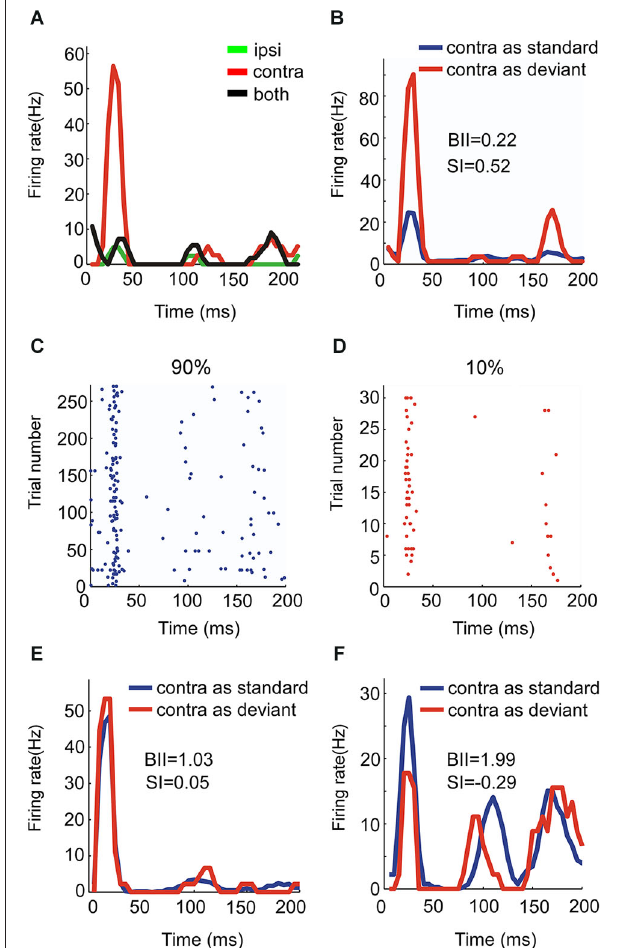
FIGURE 3 | Responses of EO neurons to noise burst with two locations presented in oddball procedure. (A) Peristimulus time histograms showing one neuron’s monaural and binaural responses respectively. (C, D) Raster displays showing its responses to 270 times of standard (90% appearing probability) and 30 times of deviant (10% appearing probability) stimuli presented to the contralateral ear. (B) PSTH of responses shown in ( C and D ). (E, F) Another two examples of EO neurons with BII and SI